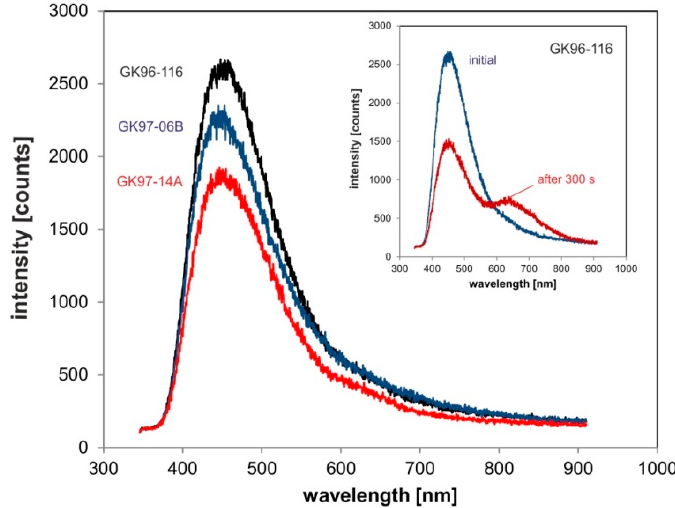
Figure 5. Initial CL emission spectra of quartz from the garnet-cordierite-sillimanite-K-feldspar zone; the dominating 450 nm band decreases during electron irradiation, whereas the 650 nm band intensity increases (see inset—the irradiation time of the electron beam was set to 300 s to see the changes of the spectra more clearly).